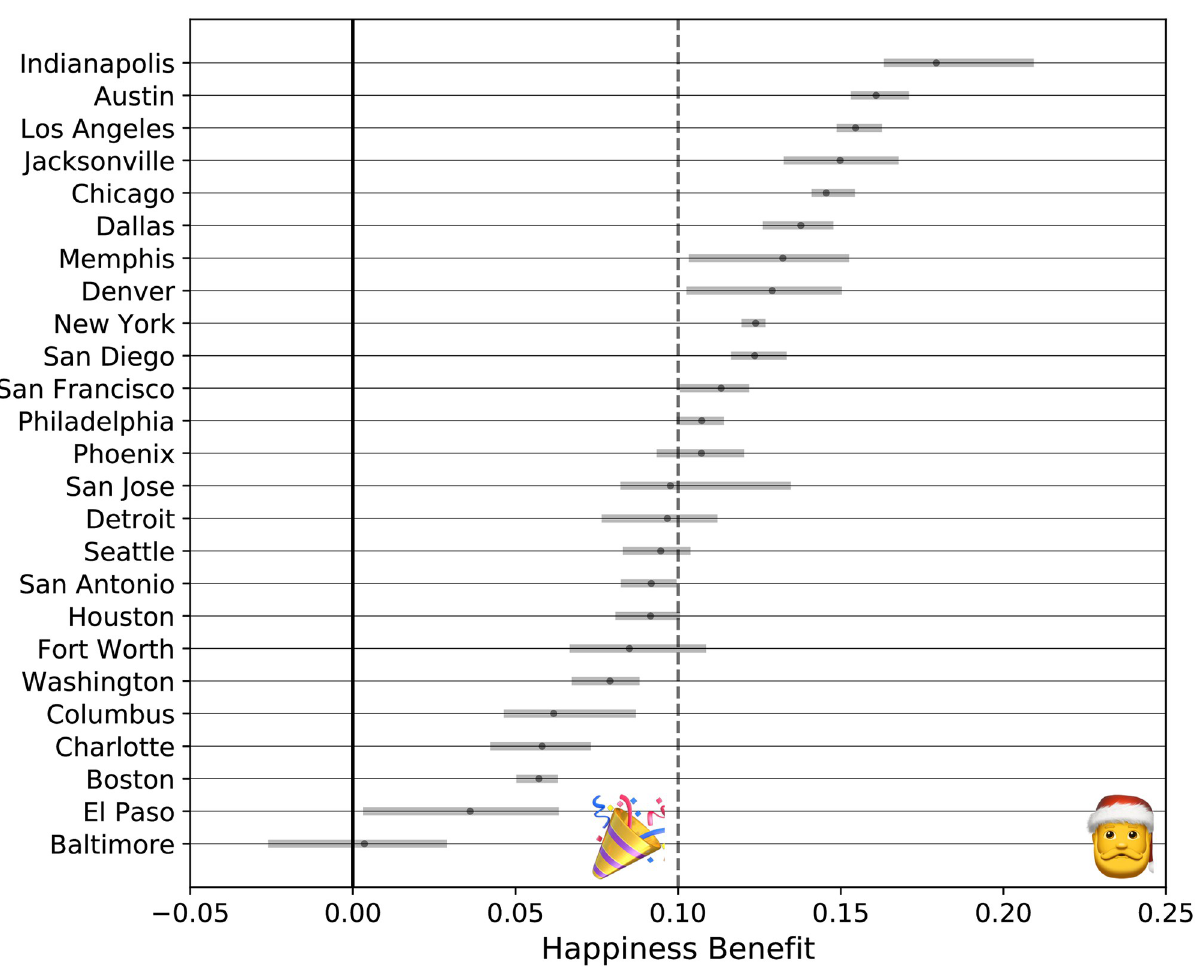
Fig 1. Happiness benefit by city. Happiness benefit is the difference in happiness score between in-park tweets and out-of-park tweets sent at roughy the same time. The full range of values is estimated from 10 bootstrap runs in which 80% of tweets were randomly selected. The dark grey dots represent the mean value from bootstrap runs. The solid line marks a happiness benefit of 0, and the dotted line is average happiness benefit across all 25 cities. Emojis denote the happiness benefit typically observed on New Year’s Day and Christmas for all English tweets.